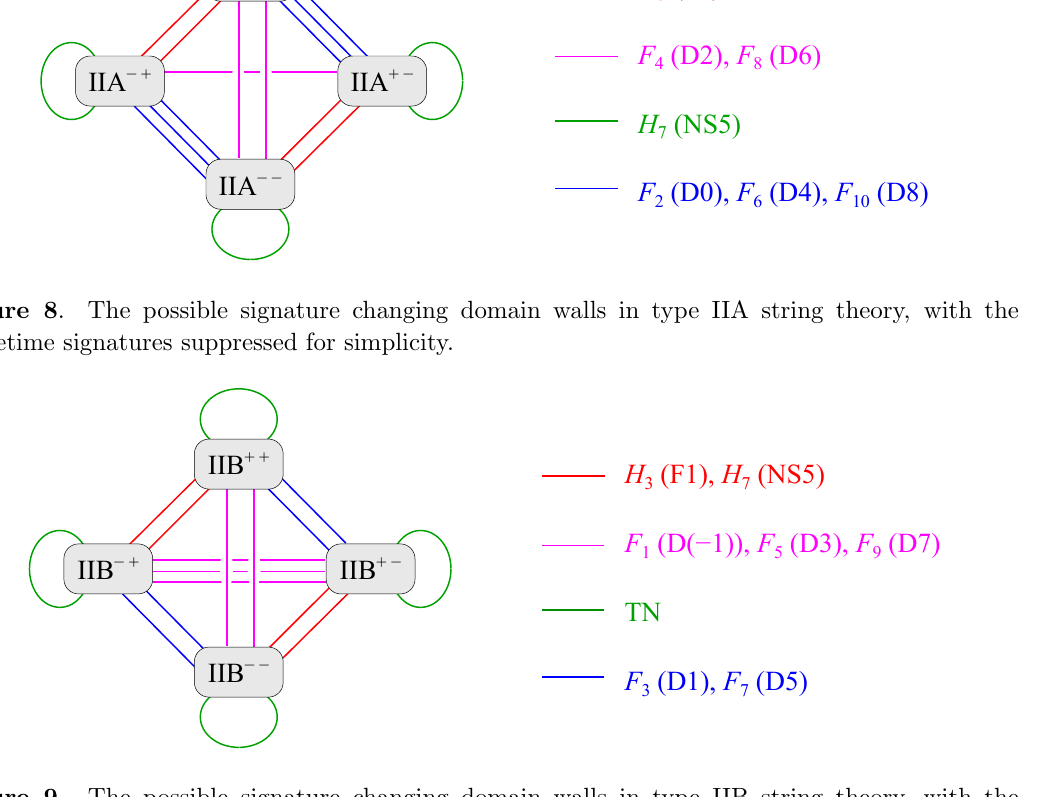
Figure 9 . The possible signature changing domain walls in type IIB string theory, with the spacetime signatures suppressed for